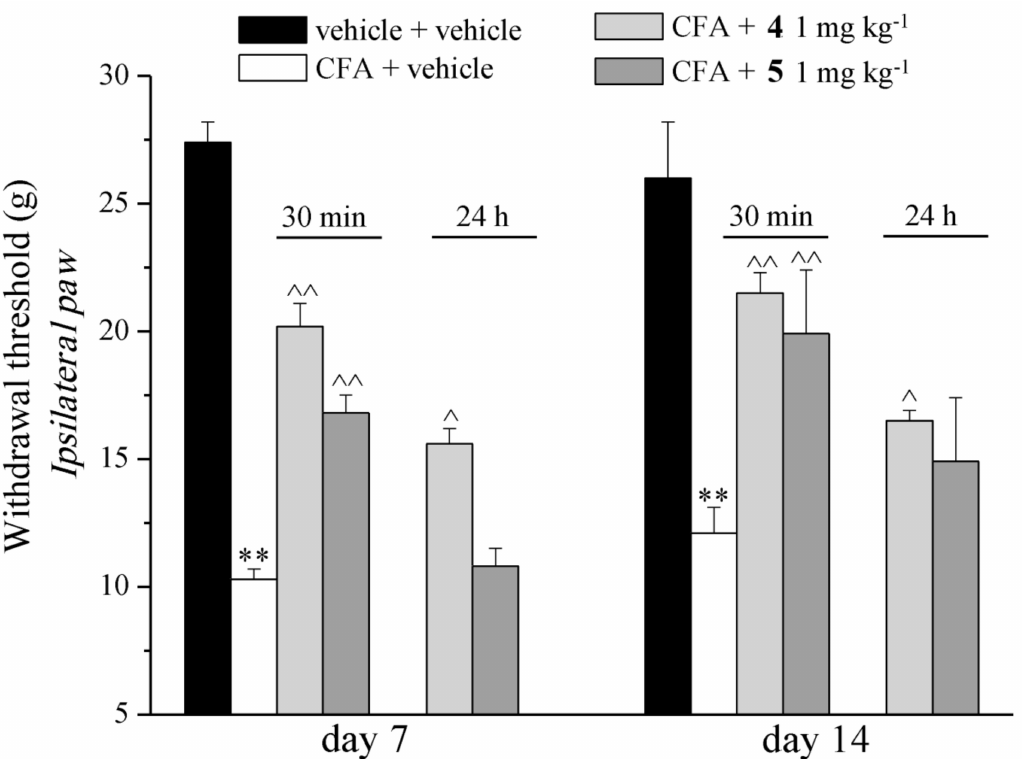
Figure 2. Preventive pain reliever e ff ect of compounds 4 and 5 in a CFA i.a. injection-induced RA model in rats. The von Frey test was used to assess the hypersensitivity toward non-noxious mechanical stimulus. Compounds 4 and 5 (both 1 mg kg − 1 ) were suspended in 1% CMC and orally daily administered starting on the day of CFA i.a. injection. Measurements were performed on day 7 and 14. Control animals were treated with vehicle. The value represent the mean of eight rats performed in two di ff erent experimental sets. ** p < 0.01 vs. vehicle + vehicle-treated animals; ˆ p < 0.05 and ˆˆ p < 0.01 vs. CFA + vehicle-treated